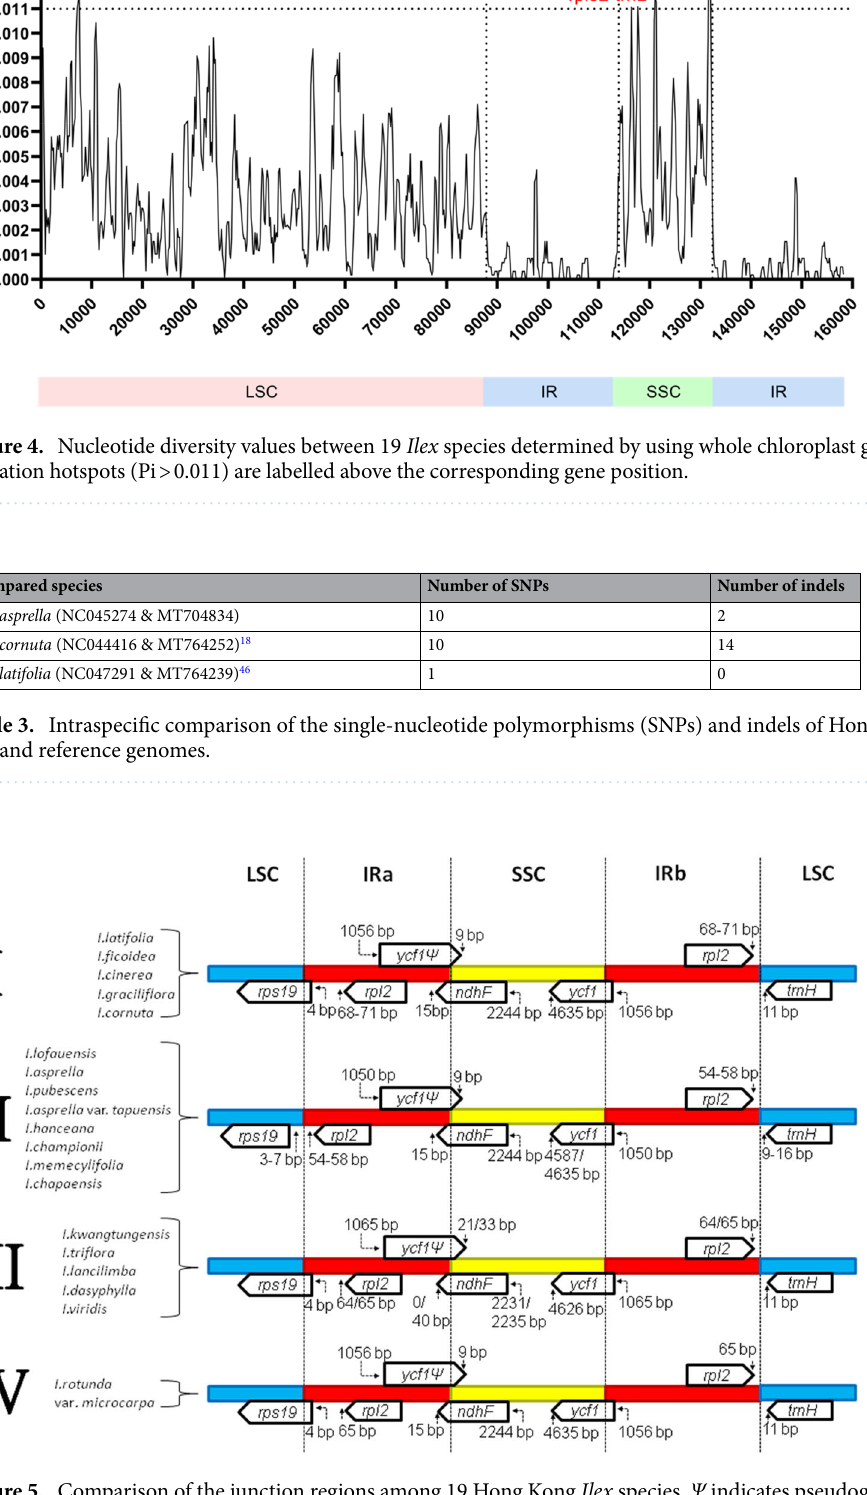
Figure 5. Comparison of the junction regions among 19 Hong Kong Ilex species. Ψ indicates pseudogenes. Slashes indicate the location on the genomes. Numbers above the genes denote the distance between the end of the gene and the border sites. The figure is not to